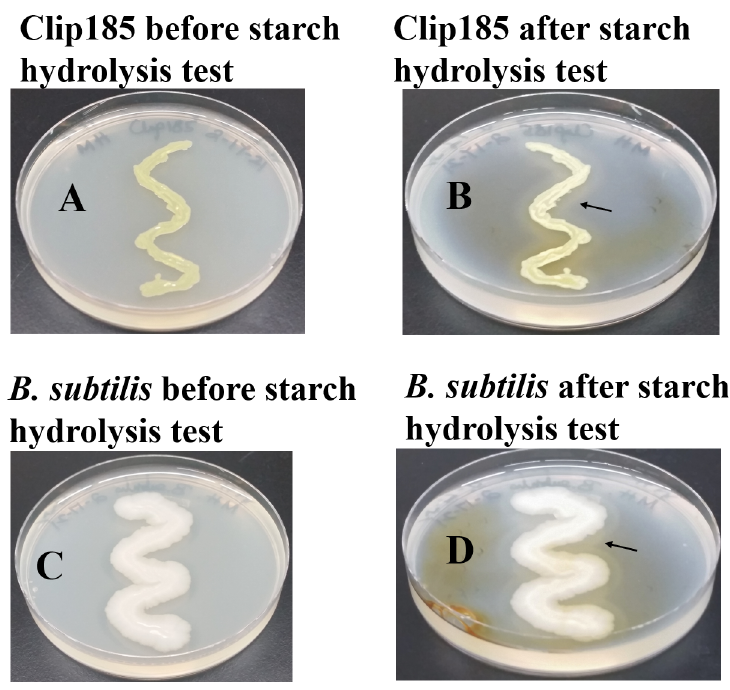
Figure 9. Clip185 can hydrolyze starch. (A) 3 days -growth of Clip185 at 30 ° C on Mueller-Hinton medium which contains 0.15% starch. (B) Clip185 Mueller-Hinton plate shown in (A) was treated with Gram iodine. (C) 3 days-growth of Bacillus subtilis at 30 ° C on Mueller-Hinton medium which contains 0.15% starch. (D) B. subtilis Mueller-Hinton plate shown in (C) treated with Gram iodine. Black arrows indicate the clear starch-hydrolyzed zones around the bacterial forward and reverse 16S rRNA gene-specific PCR primers are represented by black arrows in the 16S rRNA gene schematics (Figure 10A). A 445 bp amplicon was generated upon PCR amplification of the partial 16S rRNA gene of Clip185 (Underlying data 42 ). This 445 bp amplicon was cloned. A clone harboring the Clip185 amplicon was then sequenced to determine the taxonomic identity of Clip185.